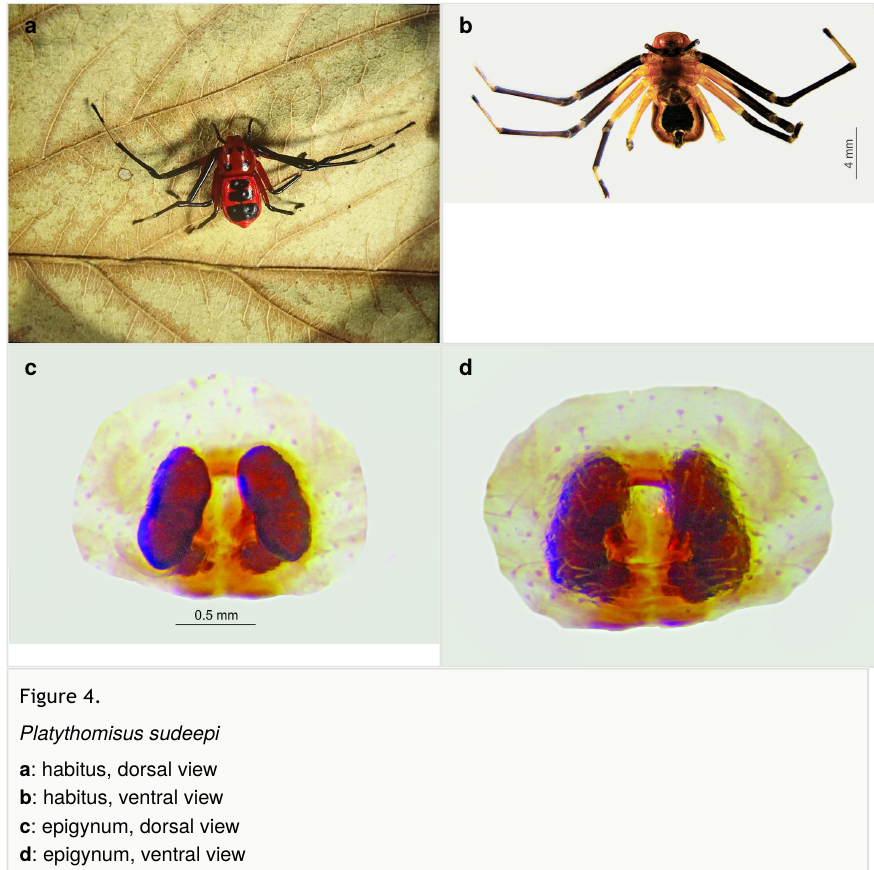
Platythomisus sudeepi a : habitus, dorsal